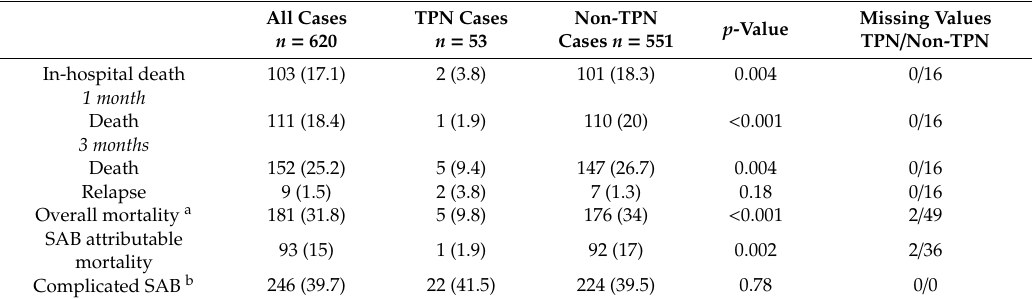
Figure 3. Kaplan–Meier curves for survival time in patients with S. aureus bacteremia. TPN: total parenteral nutrition. Log-rank test: p = 0.001. Table 3. In-hospital and cumulative mortality of TPN and non-TPN cases.